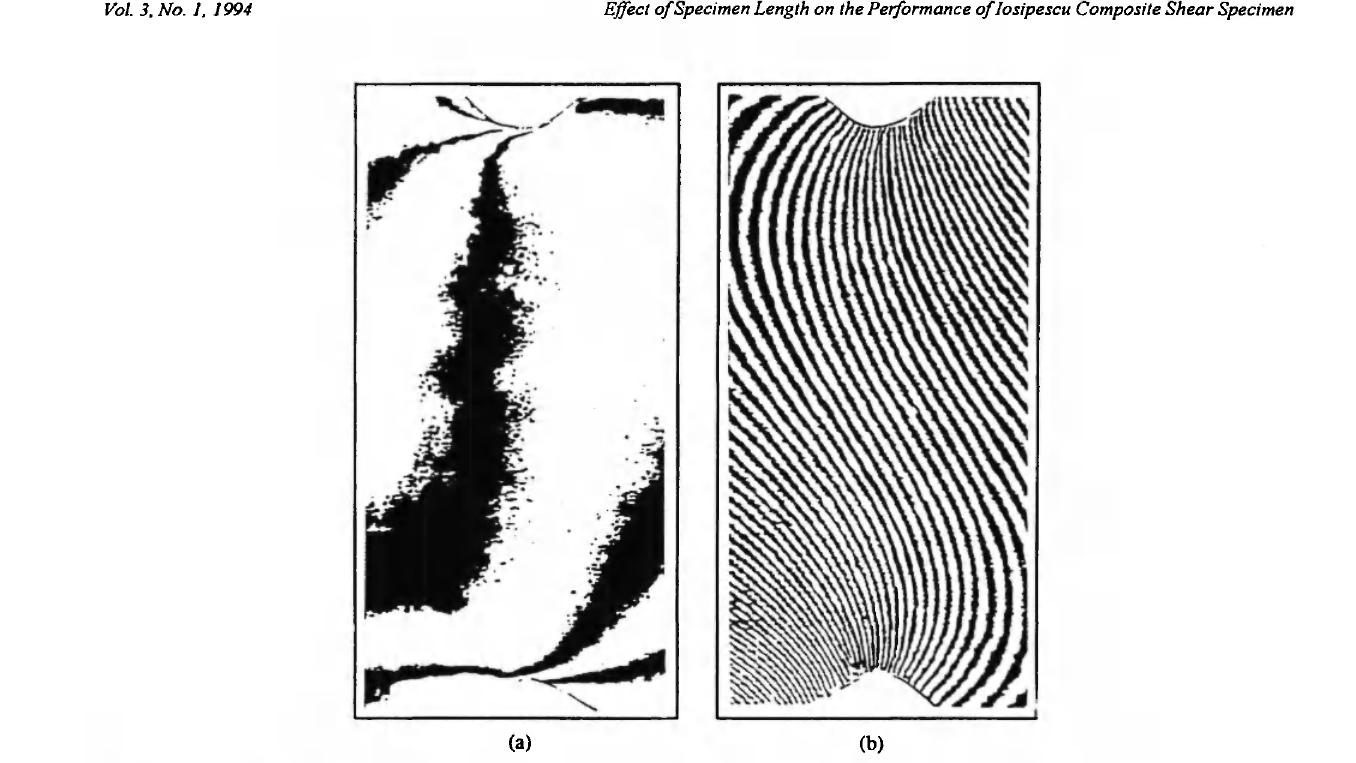
Fig. 11: (a) u-field, (b) v-field moir6 fringe patterns for the subscale 0° graphite-epoxy specimen at an applied load of 321N.